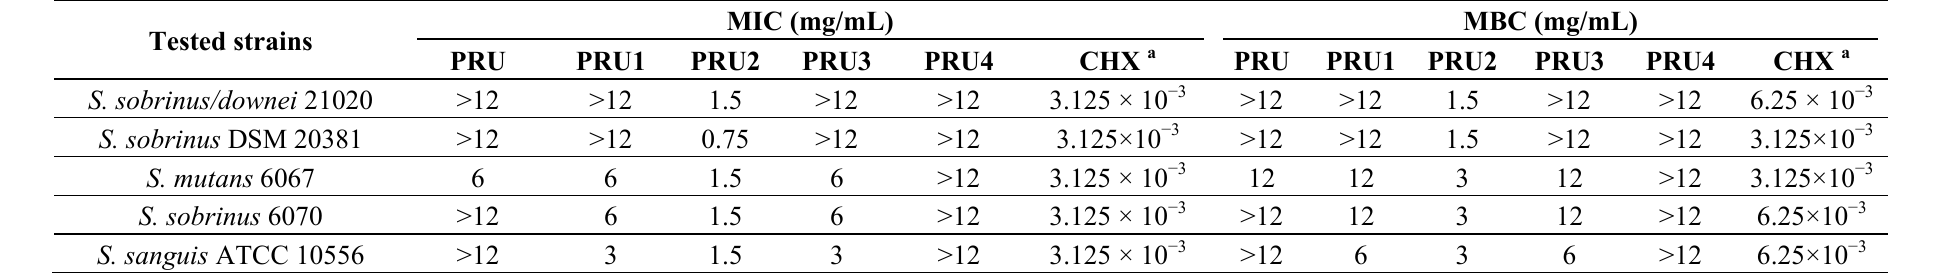
Table 4. MIC and MBC values of D. rupestris samples against mutans